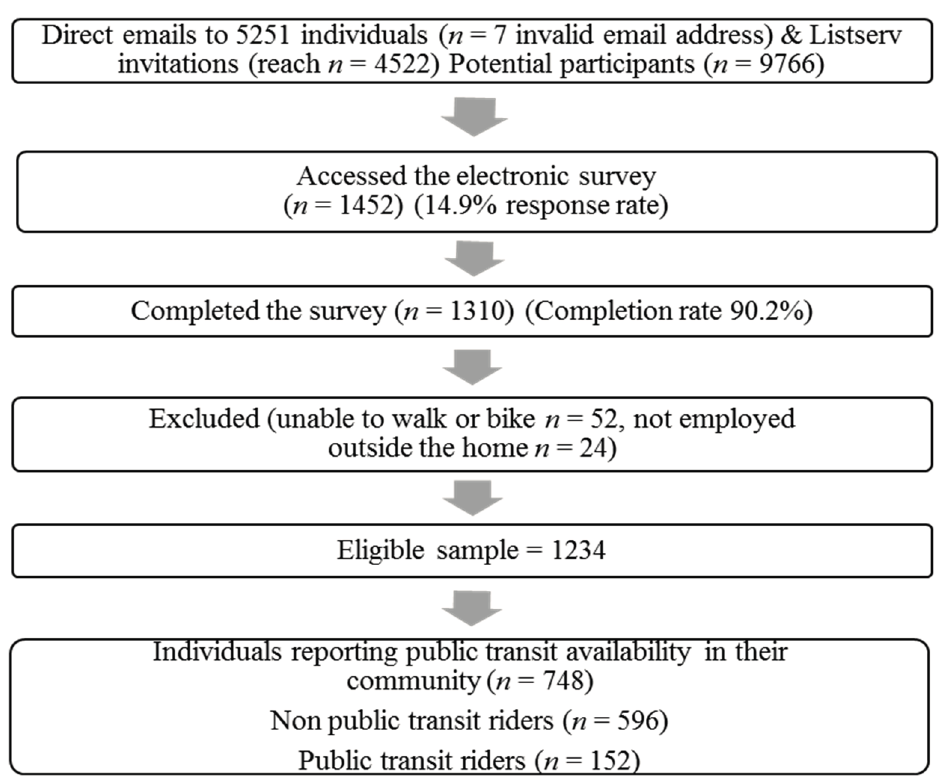
Figure 1. Participant